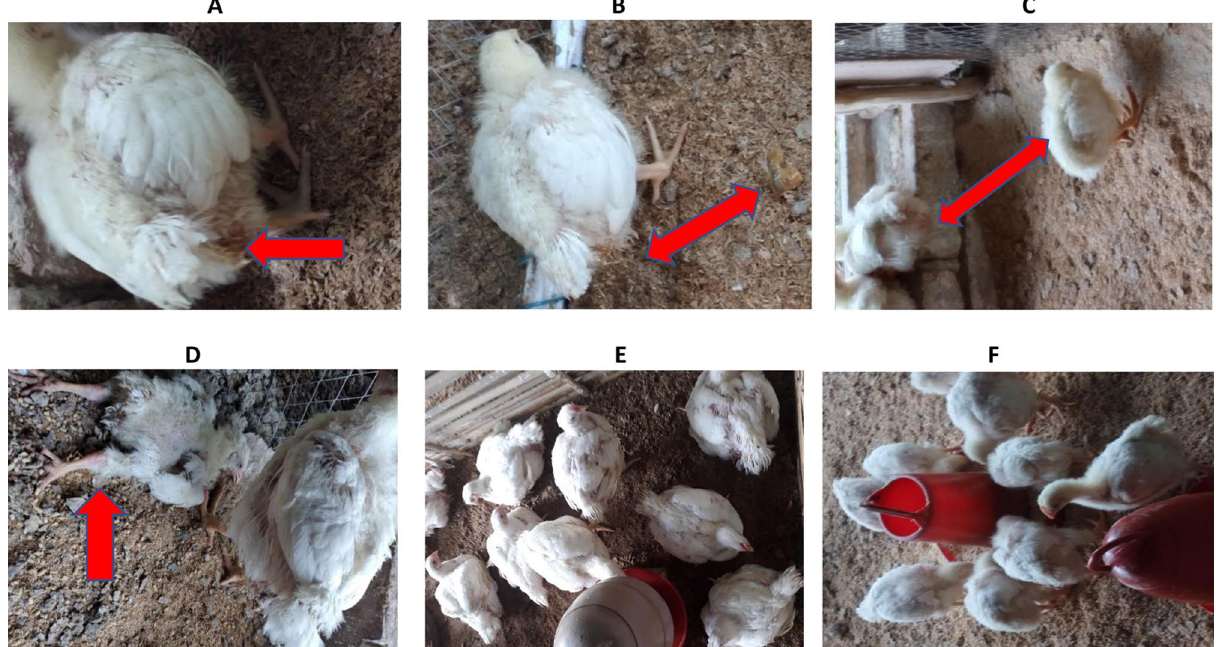
Figure 1. Symptoms in Pasteurella multocida challenged groups supplemented with antibiotic (PC+) and control (NC+); ( A ) Yellowish-grey diarrhoea appeared on the cloaca, ( B ) Yellowish-grey diarrhoea appeared on the cloaca and littered, ( C ) Depression and isolation, ( D ) Moribund, lameness and ruffled feathers, ( E ) Healthy and active probiotics supplemented broilers challenged with Pasteurella multocida (Pro+), ( F ) Healthy and active probiotics supplemented broilers challenged with Pasteurella multocida